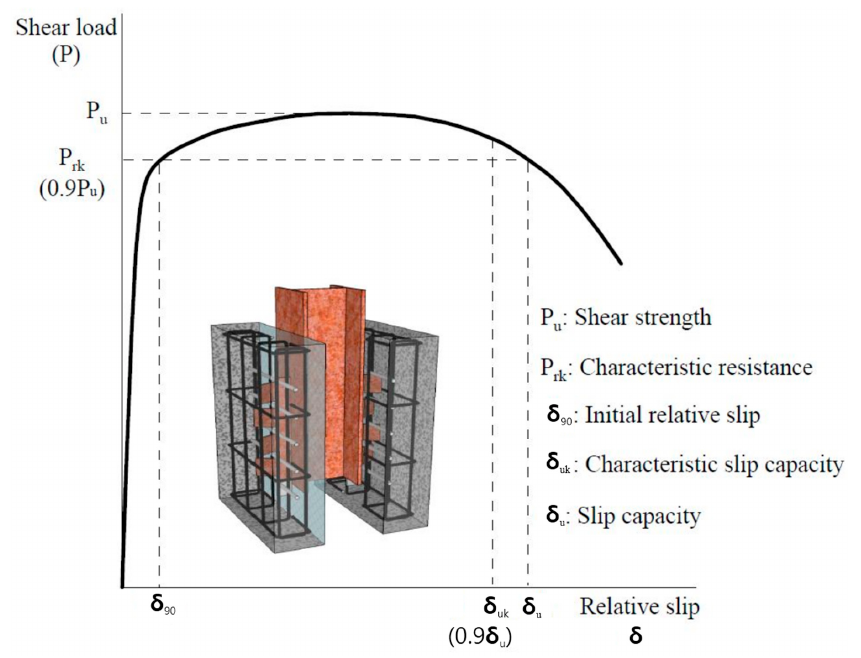
Figure 4. Determination of shear capacity and relative slip.